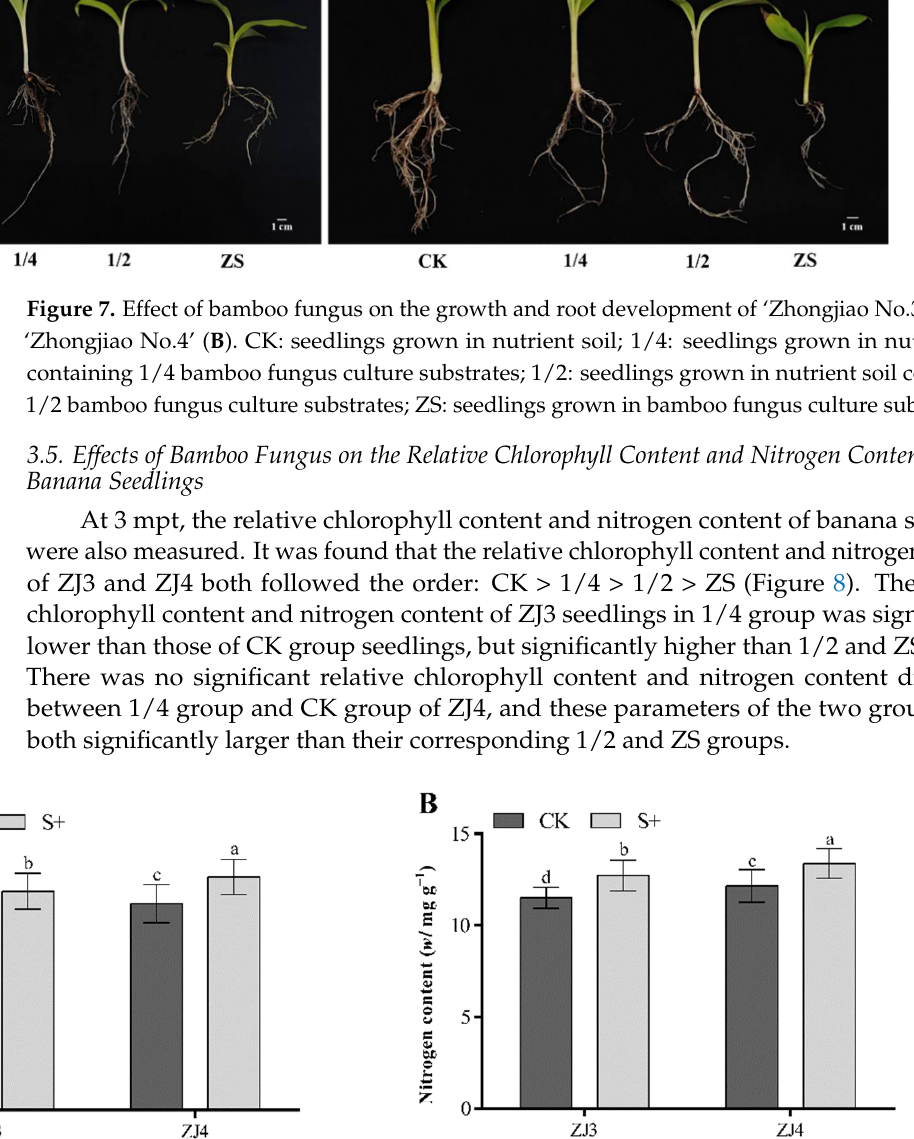
Figure 8. Effects of bamboo fungus on relative chlorophyll content ( A ) and nitrogen content ( B ) in leaves of ‘Zhongjiao No.3 ’ (ZJ3) and ‘Zhongjiao No.4 ’ (ZJ4) banana seedlings. CK: seedlings grown in nutrient soil; 1/4: seedlings grown in nutrient soil containing 1/4 bamboo fungus culture substrates; 1/2: seedlings grown in nutrient soil containing 1/2 bamboo fungus culture substrates; ZS: seedlings grown in bamboo fungus culture substrates. Different letters above the bars indicate a significant difference at 0.05 level.